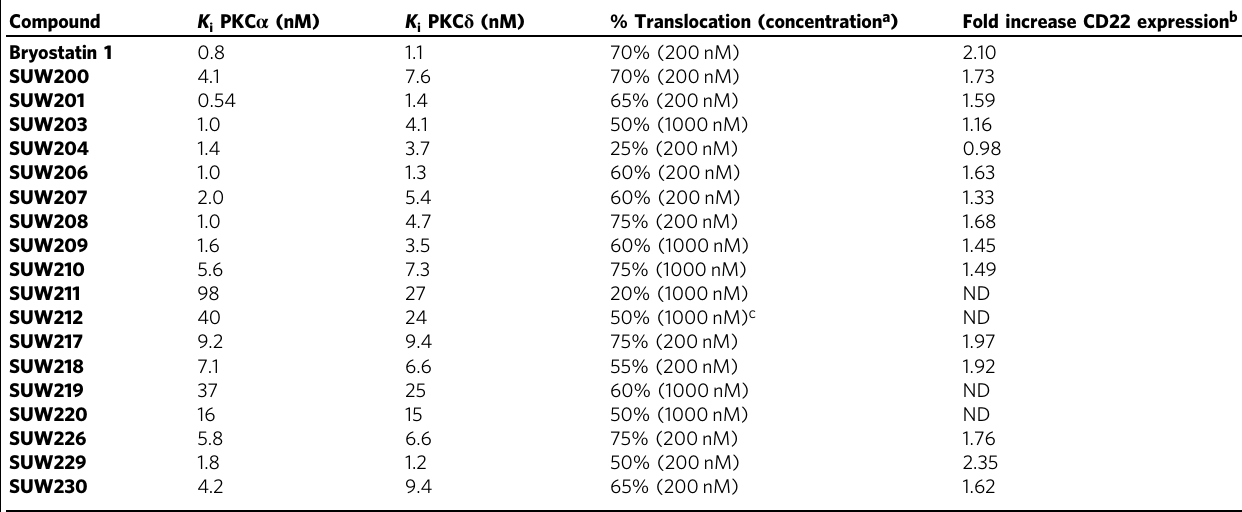
Table 1 Biological evaluation of bryostatin analogs.